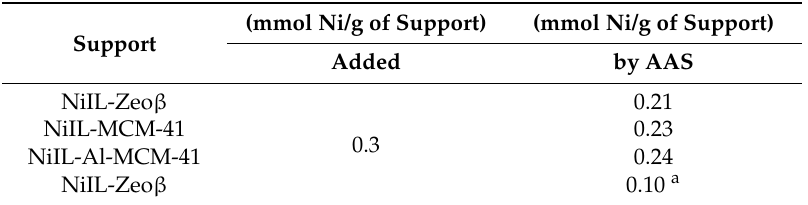
Table 3. The results from the atomic absorption spectroscopy (AAS) analysis of the β -diimine/ β -zeolite nickel